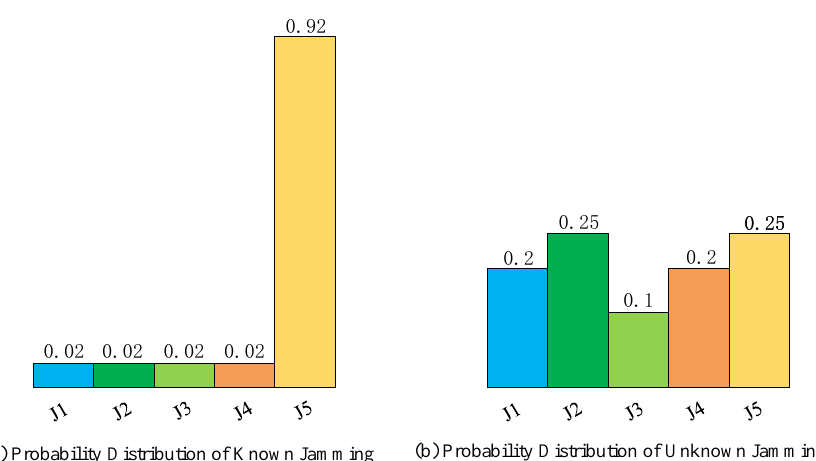
Figure 6. The difference of probability distribution between known and unknown jamming.